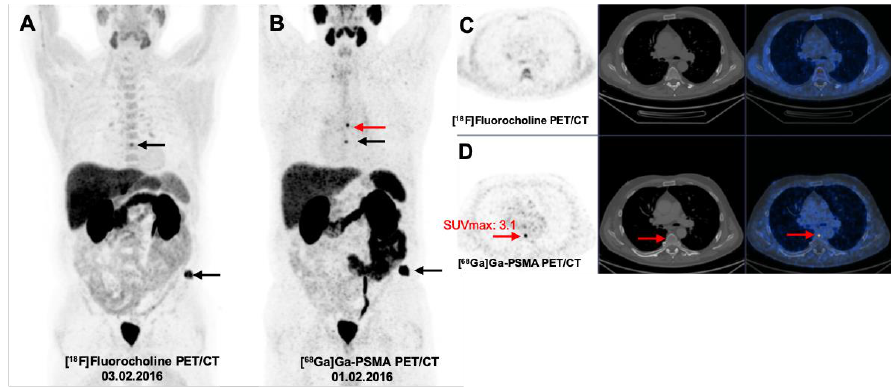
Figure 3. Prostate cancer recurrence: small skeletal metastases detected by [ 68 Ga]Ga-PSMA PET/CT (Gleason score 8, PSA: 0.7 ng/mL). ( A ) [ 18 F]Fluorocholine PET: maximum intensity projection (MIP) revealed multiple bone metastases (arrows) in the left ilium and T10 vertebra corresponding with the sclerotic changes on CT. ( B ) [ 68 Ga]Ga-PSMA PET/CT: MIP detected additional small bone metastasis on T9 vertebra (red arrows) without relevant morphological changes on CT. ( C ) transaxial views: PET (left), CT (middle), and fusion PET/CT (right) images. ( D ) transaxial views: PET (left), CT (middle) and fusion PET/CT (right) images.